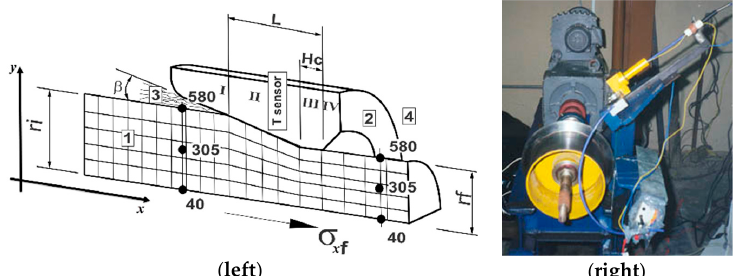
Figure 1. ( left ): A scheme of the adopted single block wire drawing process: 1: Mobile triboelement— Wire, 2: Stationary triboelement—Die, 3: Interface triboelement—Lubricant, 4: Middle triboelement: Atmosphere, I: Entrance zone, II: Reduction zone (die angle equal to 2 β ), III: Hc -Bearing zone (with a